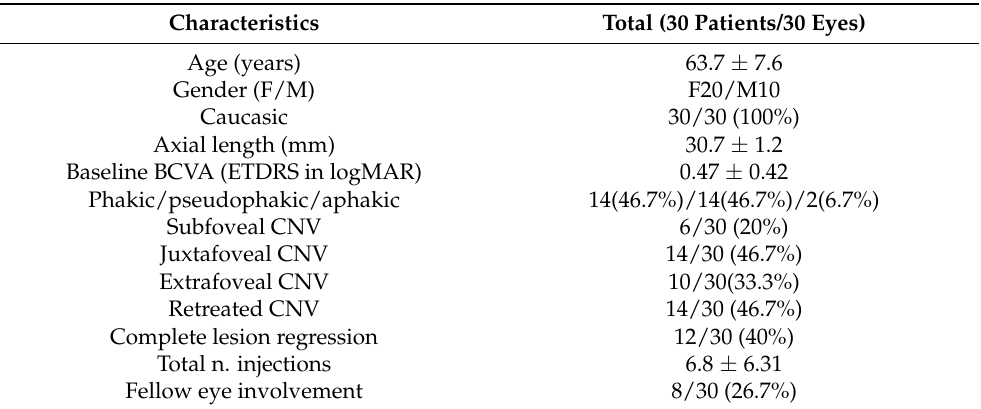
Table 1. Demographic and clinical characteristics of 30 patients (30 eyes) with mCNV treated with